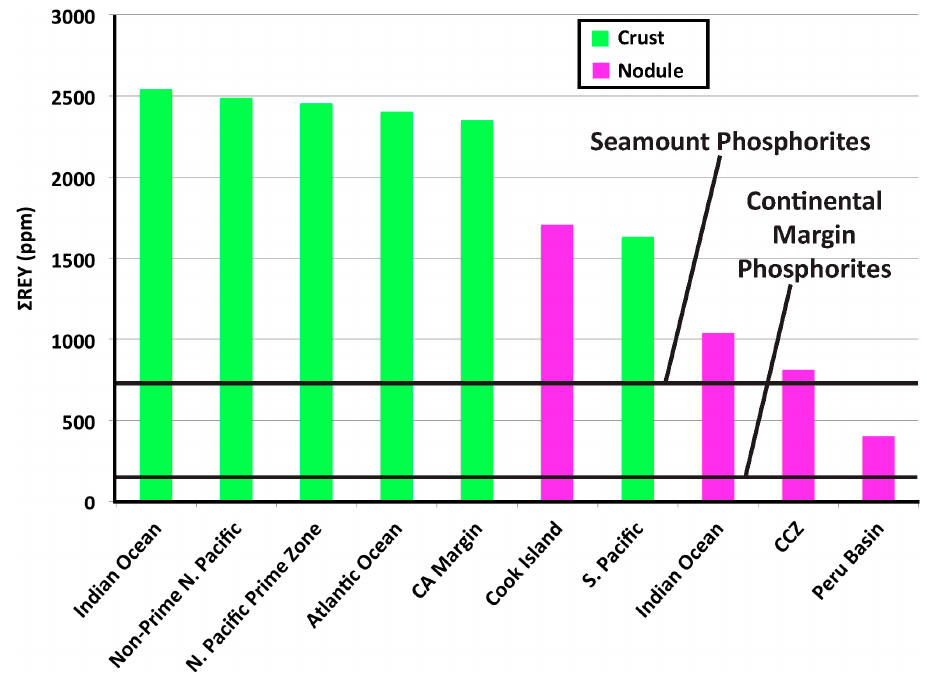
Figure 8. Bar diagram of mean total REY data for ferromanganese crusts and nodules compared to mean data for seamount and continental margin phosphorites.